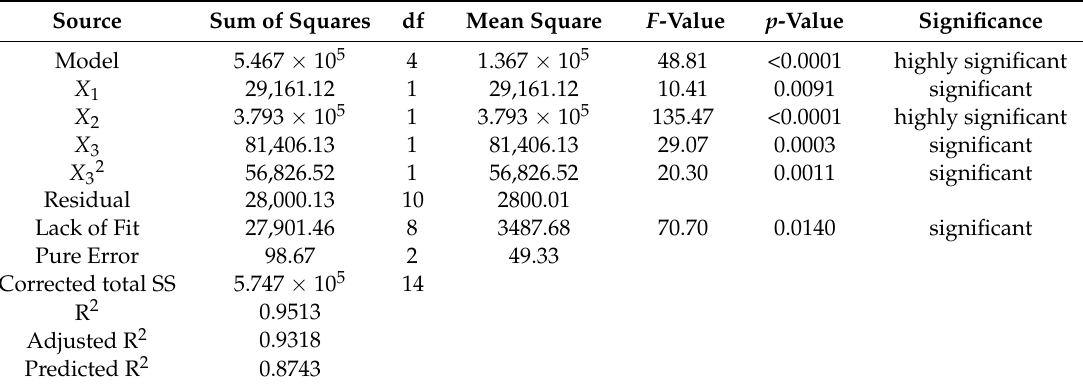
Table 6. ANOVA results for reduced model of the response variable R 2